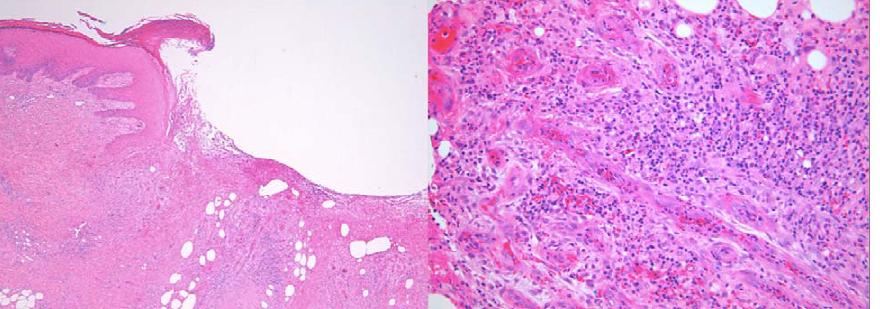
Figure 2. Histopathology of excised lesion. Left panel: Section of excised skin ulcer, showing one ulcer margin with fibrinous exudate in the base of the ulcer. Granulation tissue with a mixed inflammatory cell infiltrate extends into subcutaneous fat (H&E, orig mag 6 40). Right panel: Section from the base of the ulcer, showing granulation tissue with a mixed inflammatory cell infiltrate. Acid-fast bacilli were not seen in a Z-N stained section of the same area (H&E, orig mag 6 200).